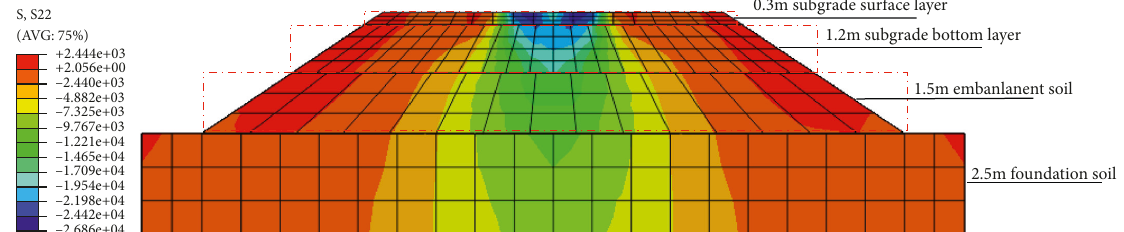
Figure 11: Cloud diagram of the vertical stress distribution of the subgrade bed.